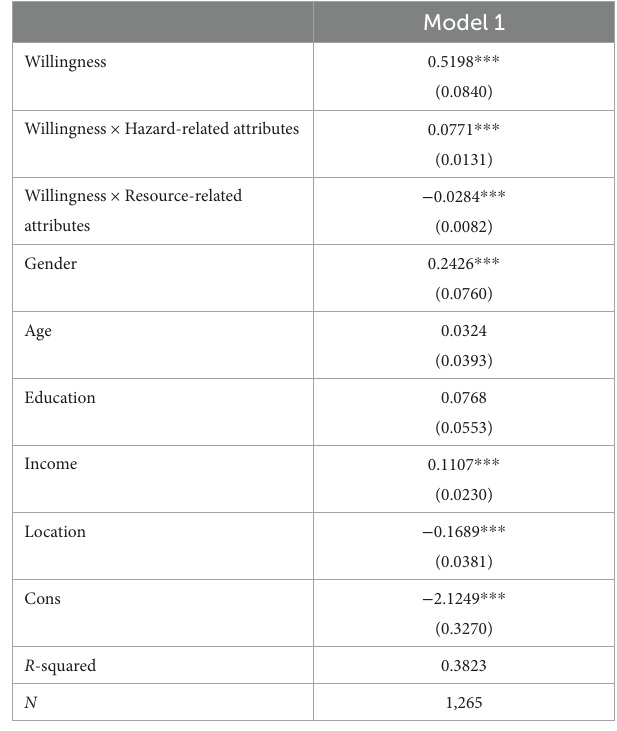
TABLE 4 The mechanism of the consumers’ self-protective willingness transforming into the consumers’ self-protective behavior during the COVID-19